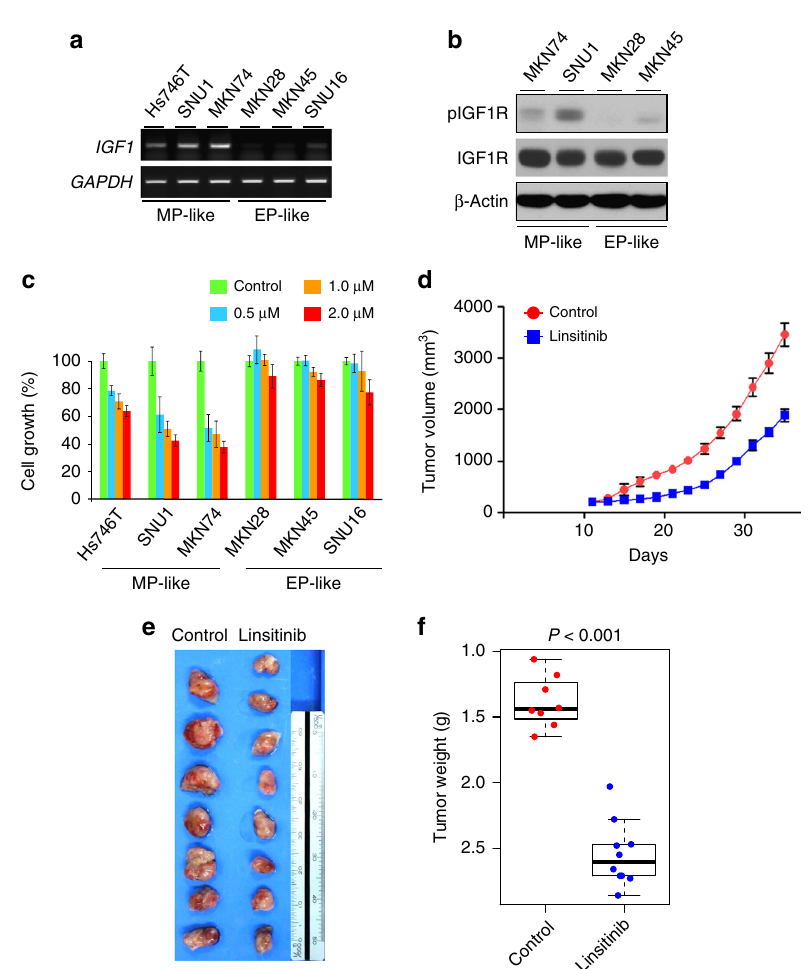
Fig. 8 IGF1/IGF1R pathway is therapeutic target for MP subtype. a Expression of IGF1 in gastric cancer cell lines. Expression was measured by qRT-PCR. b Western blot analyses in gastric cancer cell lines of MP subtype cells (MKN74 and SNU1) and EP subtype cells (MKN28 and MKN45) using antibodies against phosphorylated IGF1R (active), IGF1R (total), and β -actin. c Sensitivity of gastric cancer cell lines to linsitinib, inhibitor of IGF1R. Cell growth was measured at 96 h after treatment of linsitinib as indicated ( n = 4). d Growth of SNU1-derived xenograft tumors in mice treated with linsitinib or vehicle control. SNU1 cells were xenografted subcutaneously into the fl anks of mice. At 10 days after xenografting, linsitinib or control tartaric acid was orally administrated to mice. Tumor volume was measured on the indicated days. Error bars indicate s.e.m. e Tumors harvested after treatment of linsitinib or control vehicle. f Tumor weight after treatment of linsitinib. At 25 days after linsitinib treatment, mice were killed and tumor weights were measured ( n = 8 or 9 per treatment). Data are presented with means. P values were obtained by Student ’ s t